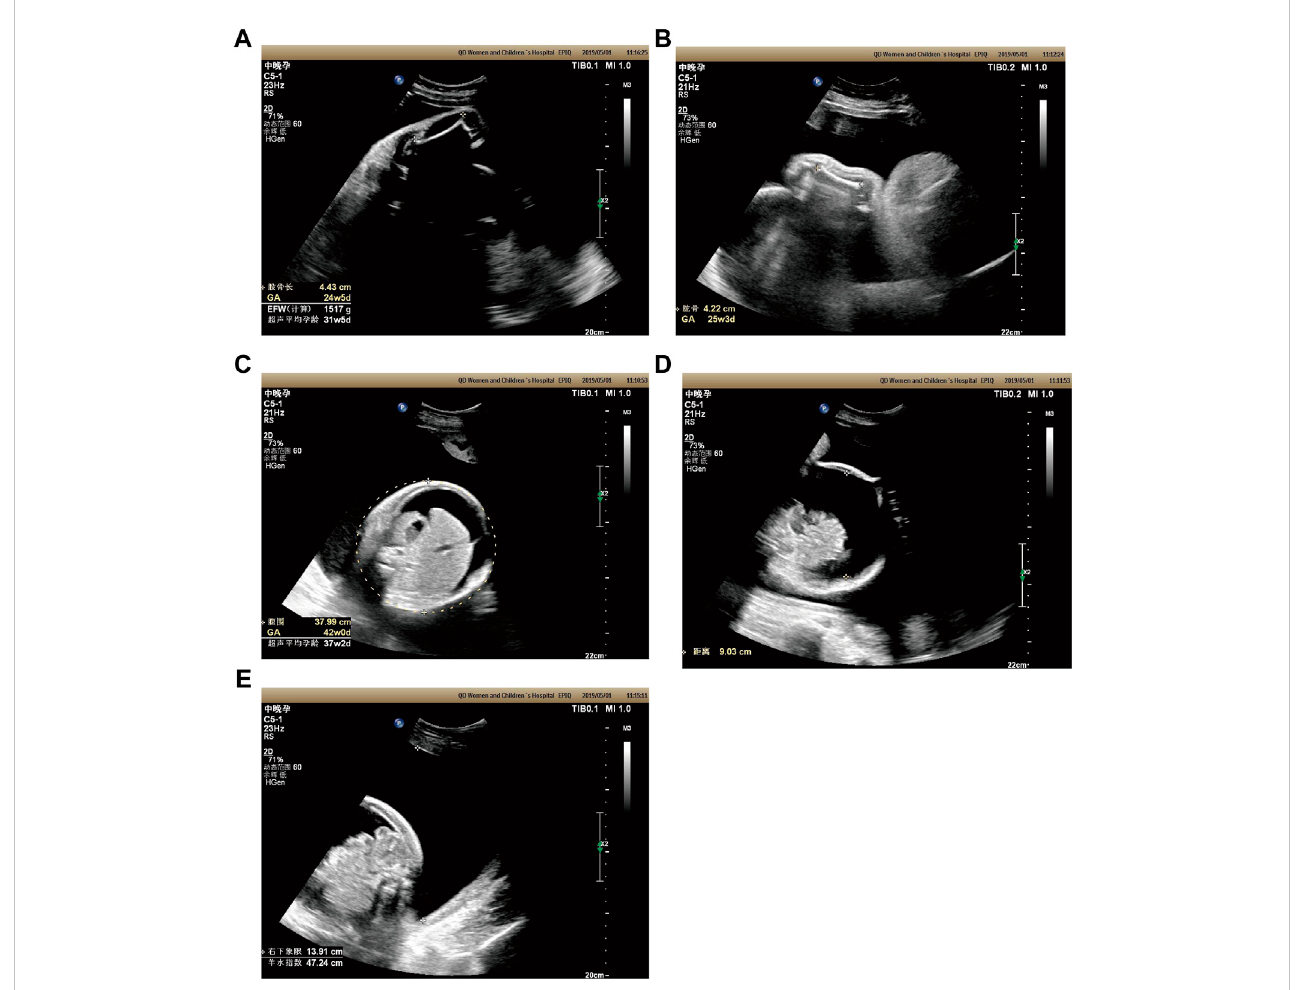
FIGURE 2 Antenatal ultrasound of foetus 2 (A) The femur length was 4.4 cm. (B) The humerus length was 4.2 cm. (C) The abdominal circumference was 38.0 cm. (D) The seroperitoneum was 9.0 cm. (E) The amniotic fl uid index was 47.0